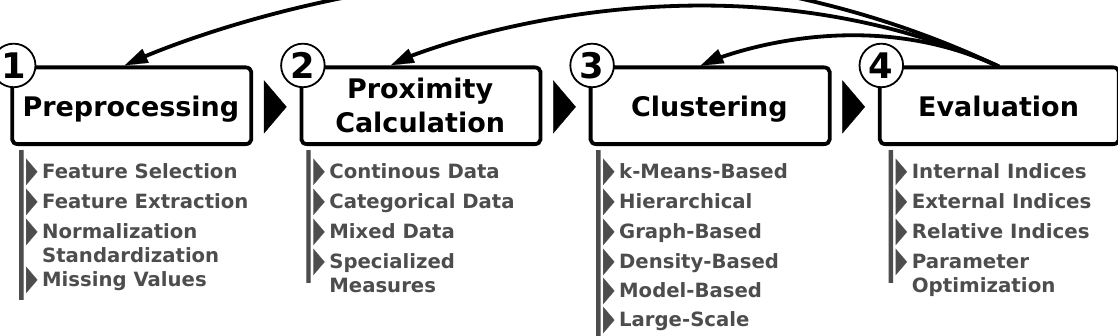
Figure 1: Overview of a typical cluster analysis. Each of the individual steps consist of several sub-steps which will be discussed in the according sections. Please note, that all steps are highly interconnected and rely on each